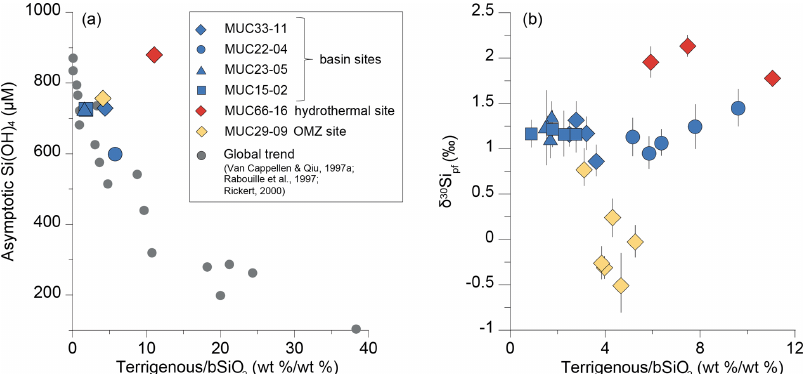
Figure 4. Asymptotic Si concentration (a) and the pore fluid δ 30 Si pf values (b) as a function of the terrigenous / bSiO 2 ratio for the basin sites, the hydrothermal site, and the OMZ site in the Guaymas Basin. An exponential increase in Si concentrations with decreasing terrige- nous / bSiO 2 ratio is observed, which is not reflected by corresponding systematic changes in δ 30 Si pf . The values for the terrigenous / bSiO 2 ratio defining the global trend (grey dots) are from the Southern Ocean, Scotia Sea, Norwegian Sea, northeastern Atlantic Ocean, Juan de Fuca Ridge, Arabian Sea, and the Peru Basin (Van Cappellen and Qiu, 1997a; Rabouille et al., 1997; Rickert, 2000).